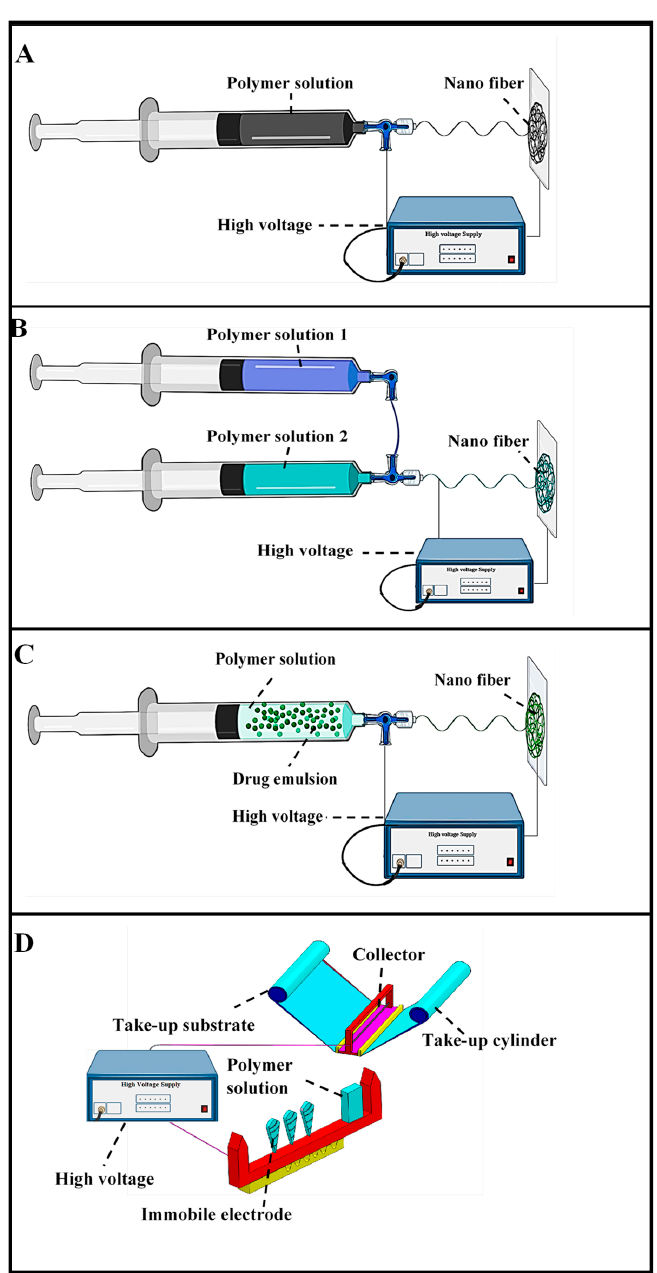
Figure 2. Electro-spinning methodologies ( A ) Blend electro-spinning, ( B ) Coaxial electro-spinning, ( C ) Emulsion electro-spinning, ( D ) Needleless electro-spinning (adapted from Repanas et al. [75], Heydari et al. [92], Manuel et al. [104], and Ambekar et al. [126]).